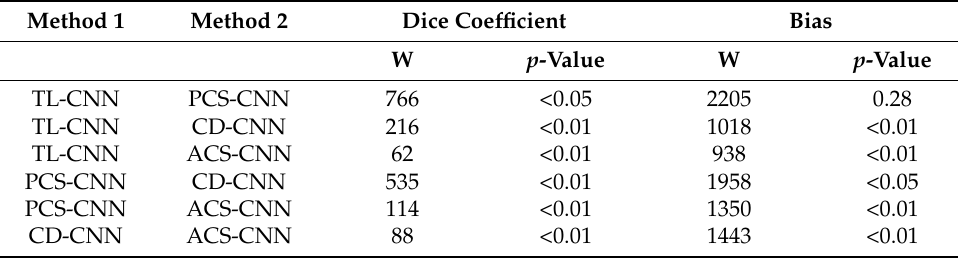
Table A4. Wilcoxon rank sum test on pairwise differences between the Dice coefficient and the bias of the volume differences. The W-statistic and p -value are shown in this table. The TL-CNN produced a significantly greater Dice coefficient than the other methods. The PCS-CNN produced a significantly greater Dice coefficient than the CD-CNN and ACS-CNN, and the CD-CNN produced a significantly greater Dice coefficient than the ACS-CNN. The TL-CNN produced a significantly smaller bias than the CD-CNN and ACS-CNN, the PCS-CNN produced a significantly smaller bias than the CD-CNN and ACS-CNN, and finally, the CD-CNN produced a significantly smaller bias than the